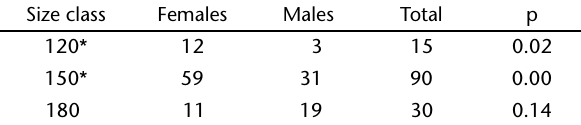
Table II. Sex ratio by size class of Trachelyopterus lucenai specimens captured in Itapeva, Quadros and Malvas lagoons in the Tramandaí River system, Rio Grande do